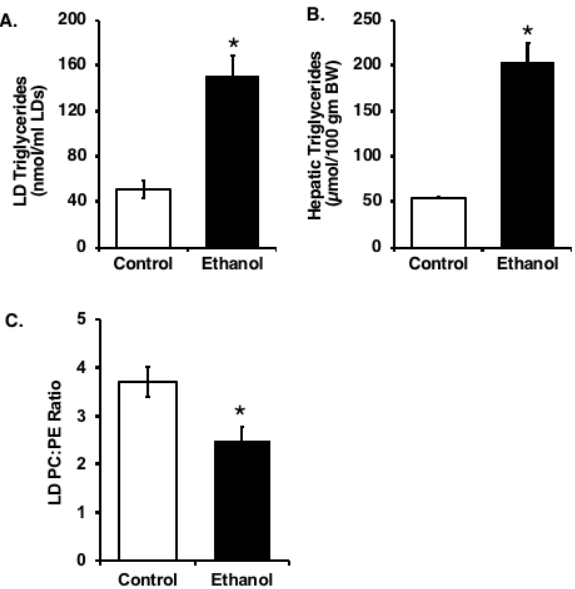
Figure 3. Chronic ethanol exposure increases the triglyceride content in the liver and alters the lipid composition of hepatic LDs. ( A ) Triglyceride levels in isolated LD fractions. ( B ) Total liver triglyceride levels expressed relative to body weight (BW). ( C ) Relative phospholipid levels in isolated LD fractions. Values are mean ± SEM (*, p < 0.05; n = 5).